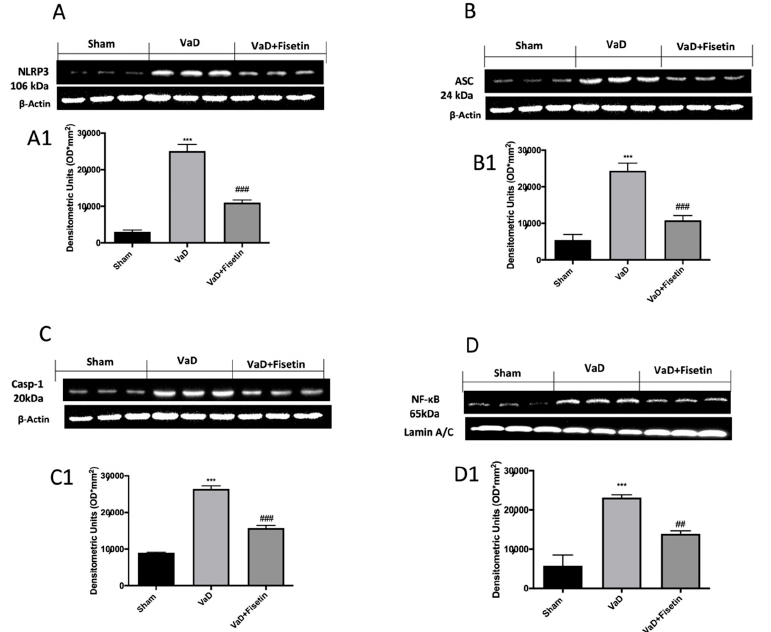
Figure 7. Fisetin administration on NF- κ B and inflammasome activation after VaD induction. Western blots on hippocampus for ( A ) NLRP3, ( B ) ASC, ( C ) caspase 1, ( D ) NF- κ B p65. Exposed is a blot of lysates (6 animals/group) with a densitometric analysis for all animals. The results in ( A1 , B1 , C1 , D1 ) are means ± SEM of 6 animals for each group. *** p < 0.001 vs. sham; ## p < 0.01 vs. VaD, ### p < 0.001 vs. VaD.